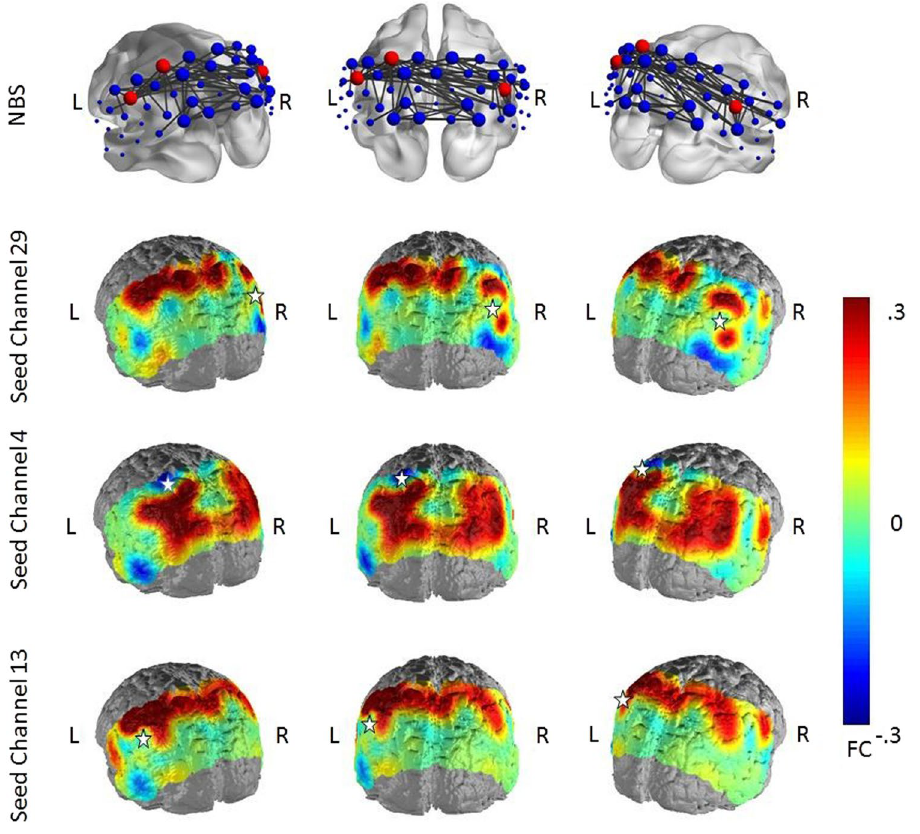
Figure 2. Differences between non-depressed and depressed subjects in FC in the NBS analysis at t = 2.7 and in selected seed regions (red nodes in the network maps). Warm colors indicate higher FC in the non-depressed subjects. Seed regions are marked by a white